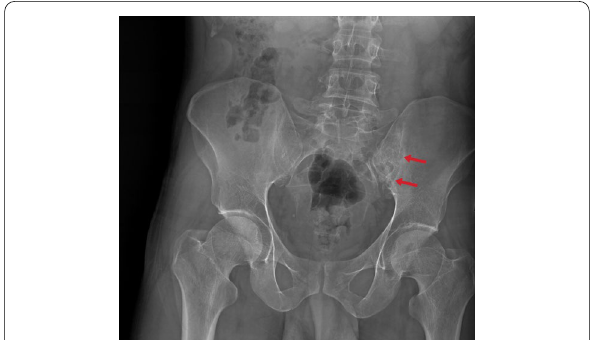
Fig. 47 Pelvic x-ray of a 46-year-old male. The late finding of tuberculous sacroiliitis is characterized by degenerative changes in the left sacroiliac joint (arrows)